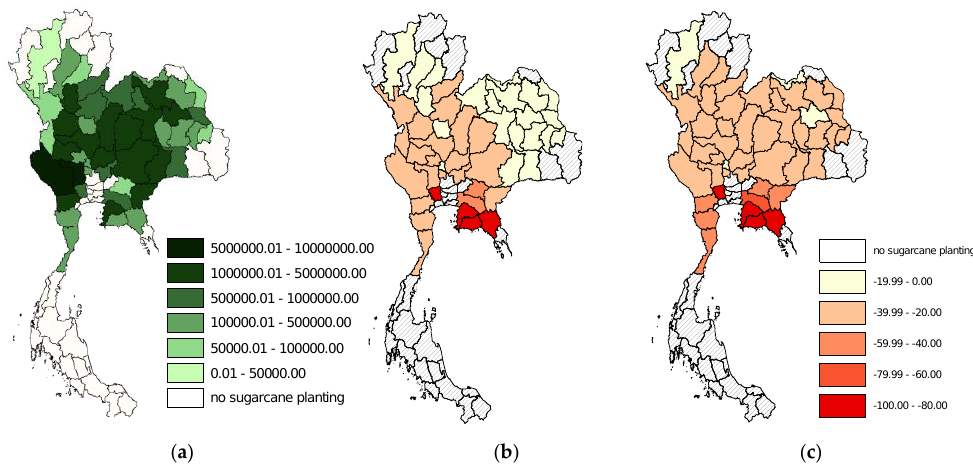
Figure 6. Projected percent changes in sugarcane production under climate change scenarios. ( a ) Baseline production (MT); ( b ) percent of change in production under RCP4.5; ( c ) percent of change in production under RCP8.5